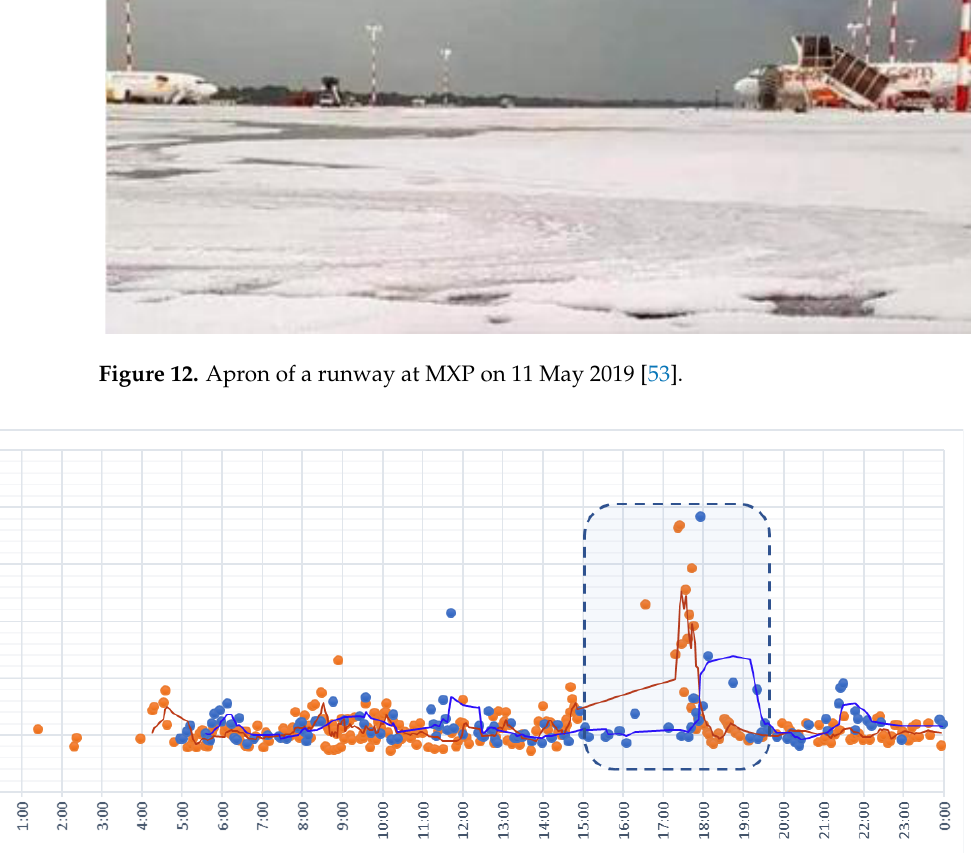
Table 1. Data summary of available historical traffic. Airport